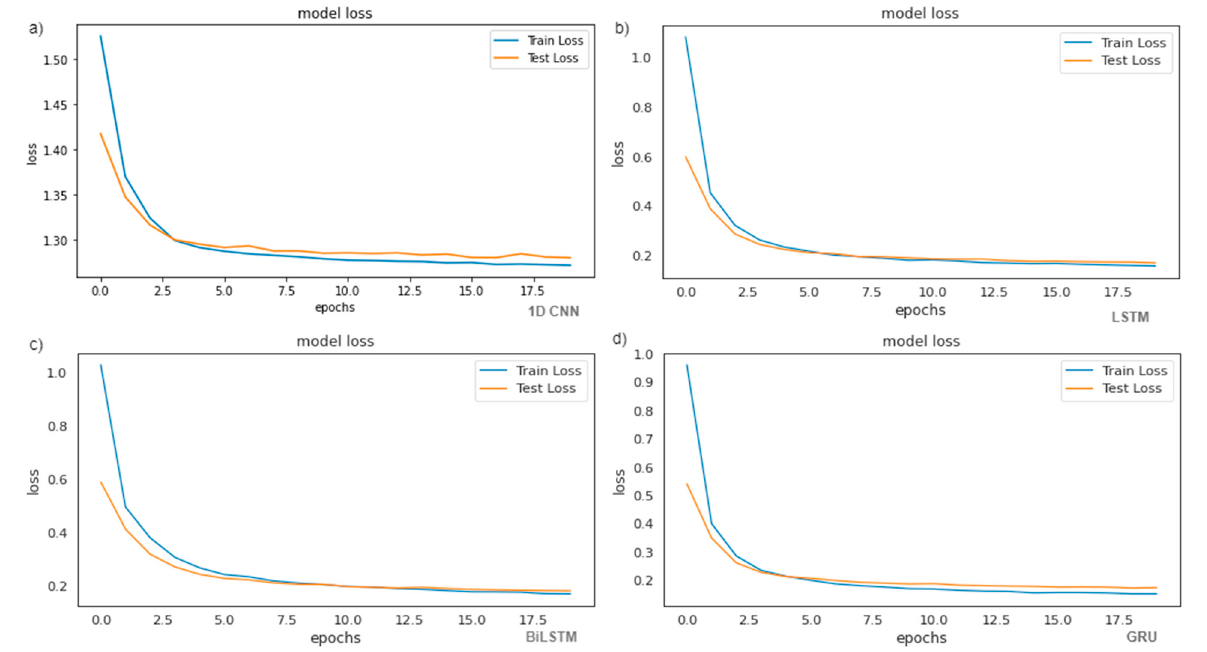
Figure 6. Prediction performances according to four models (loss vs. epochs): ( a ) Loss of the 1D CNN versus different epochs; ( b ) Loss of the LSTM versus different epochs; ( c ) Loss of the BiLSTM versus different epochs; ( d ) Loss of the GRU versus different epochs.